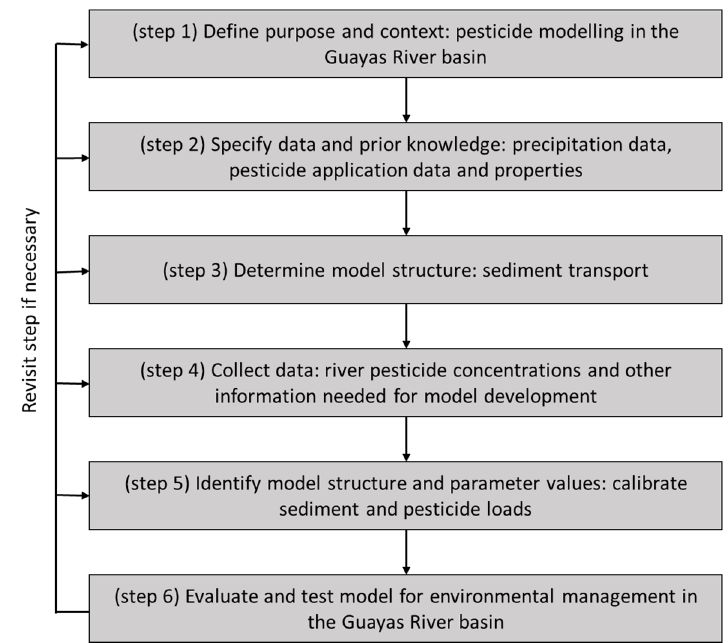
Figure 4. Revisited model building steps to further refine the Guayas River basin SWAT model (adapted from Jakeman et al. [89]). For concrete suggestions for each step, the reader is referred to the main text in Section 4.4.